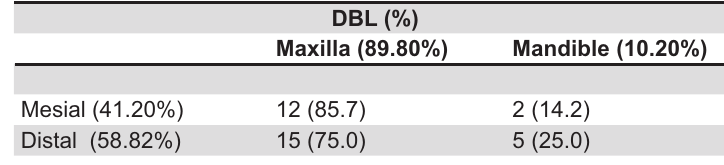
Table 5- /6789*:/-;</<,+5:,975,=;/=>/4*?;,5,@*/A=;*/B=++/04AB3/+,5*+/